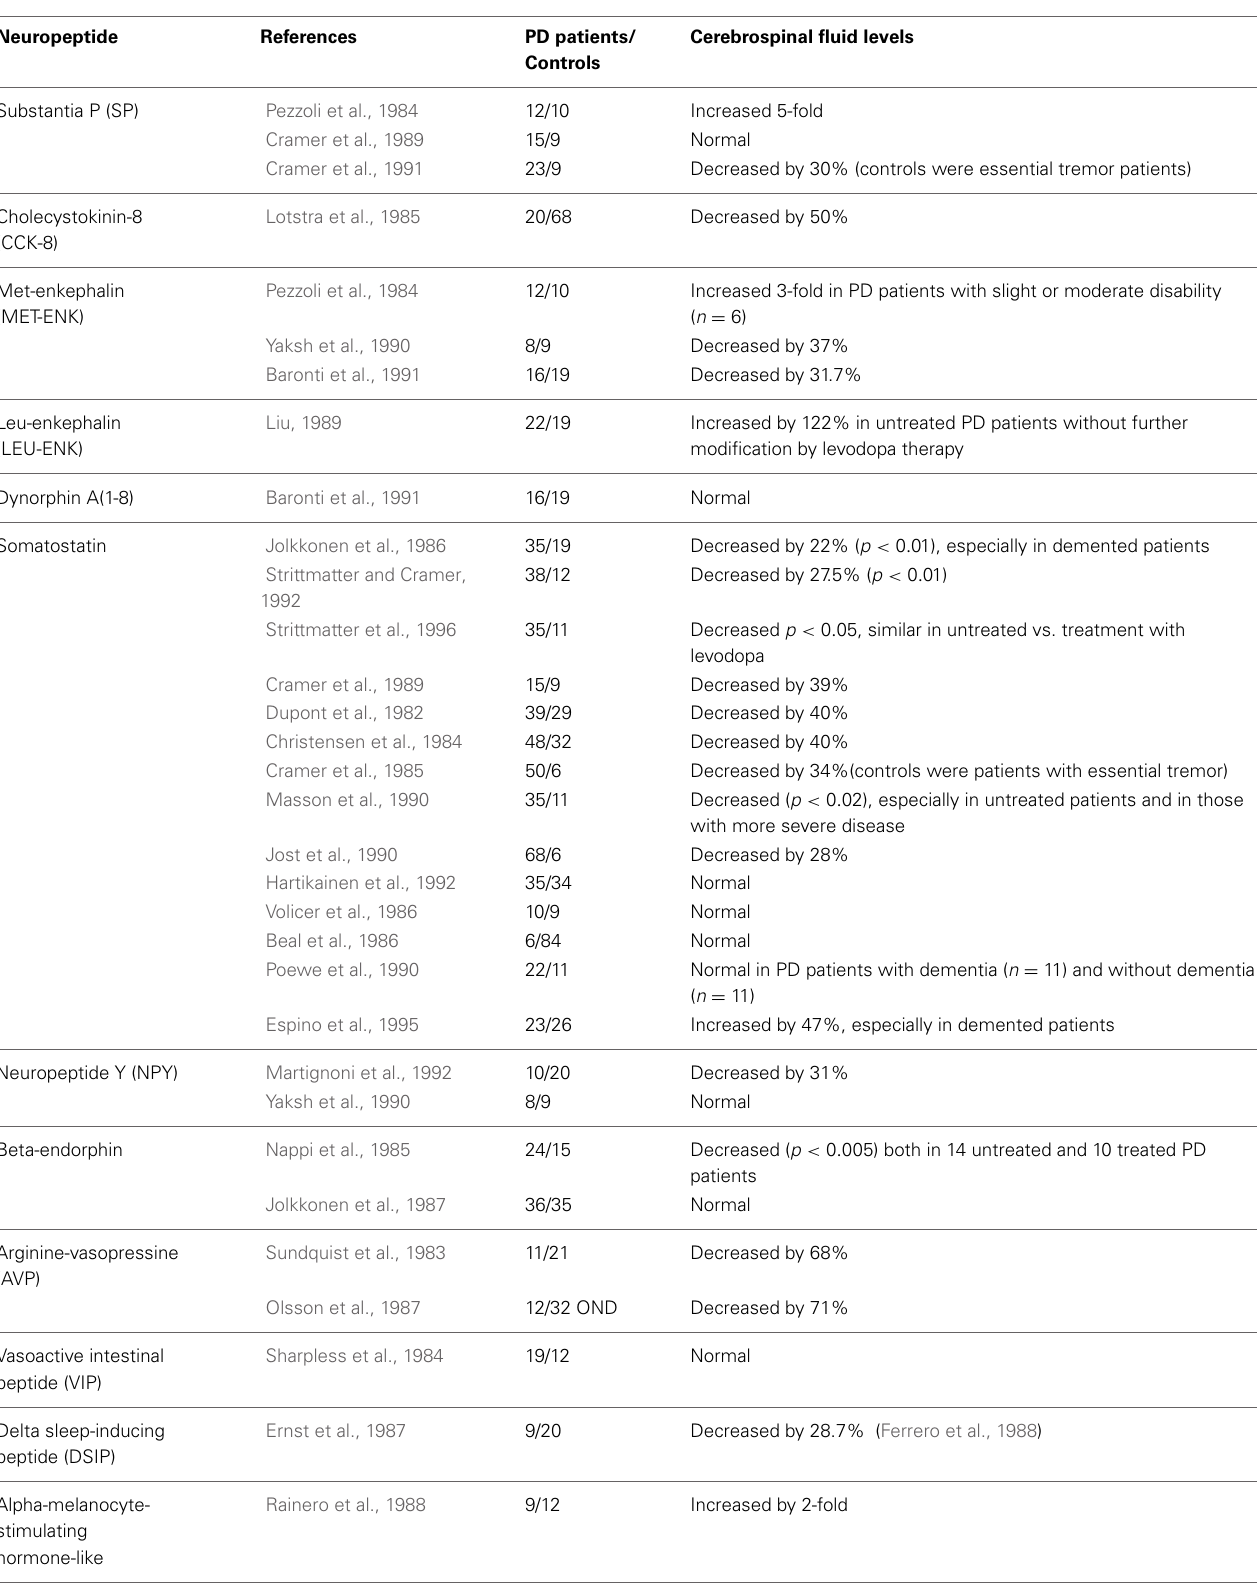
Table 2 | Alterations in CSF neuropeptide levels in PD patients compared with controls.